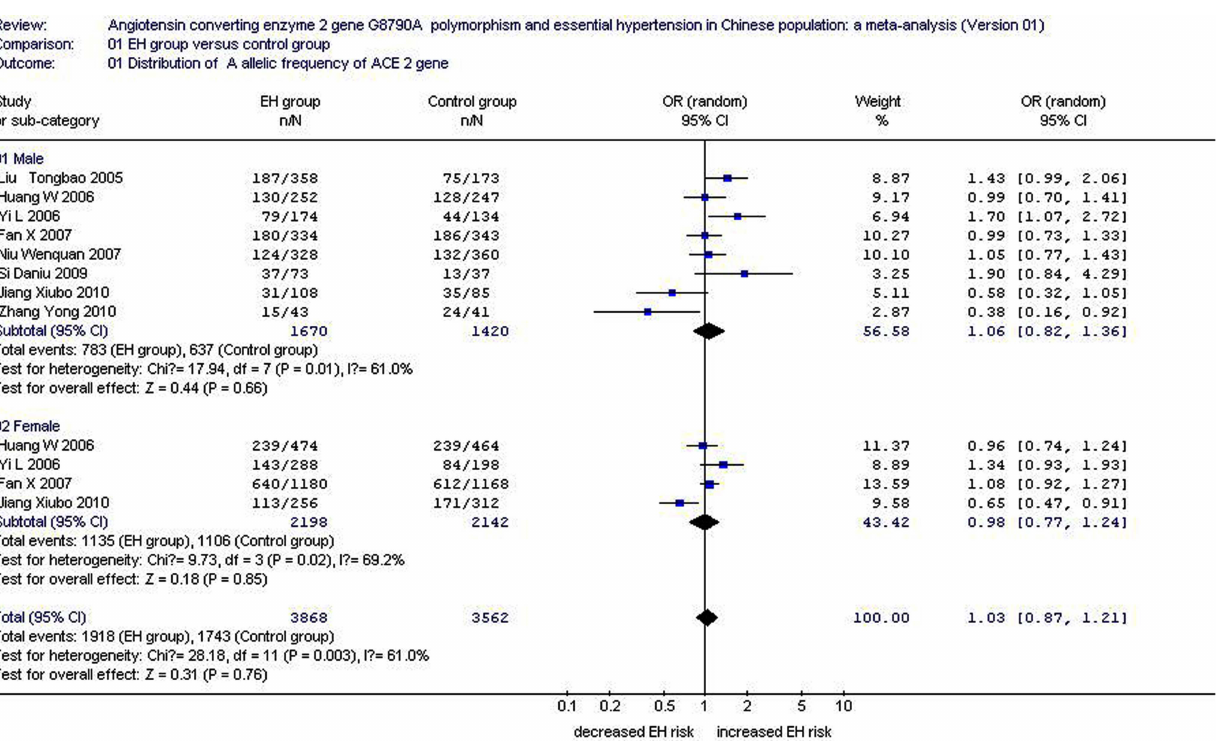
FIGURE 2 | Forest plot of EH associated withACE2 G8790A gene polymorphism under an allelic genetic model stratified by gender (distribution ofA allelic frequency ofACE2